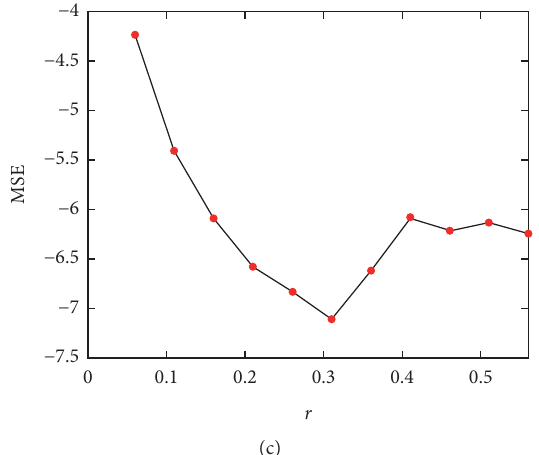
Figure 2: The analysis result of the traffic data using traditional MSE. (a) The analysis of the traffic data using MSE. (b) The MSE of Monday versus various scales under different r . (c) The MSE of Monday of scale two under different r .